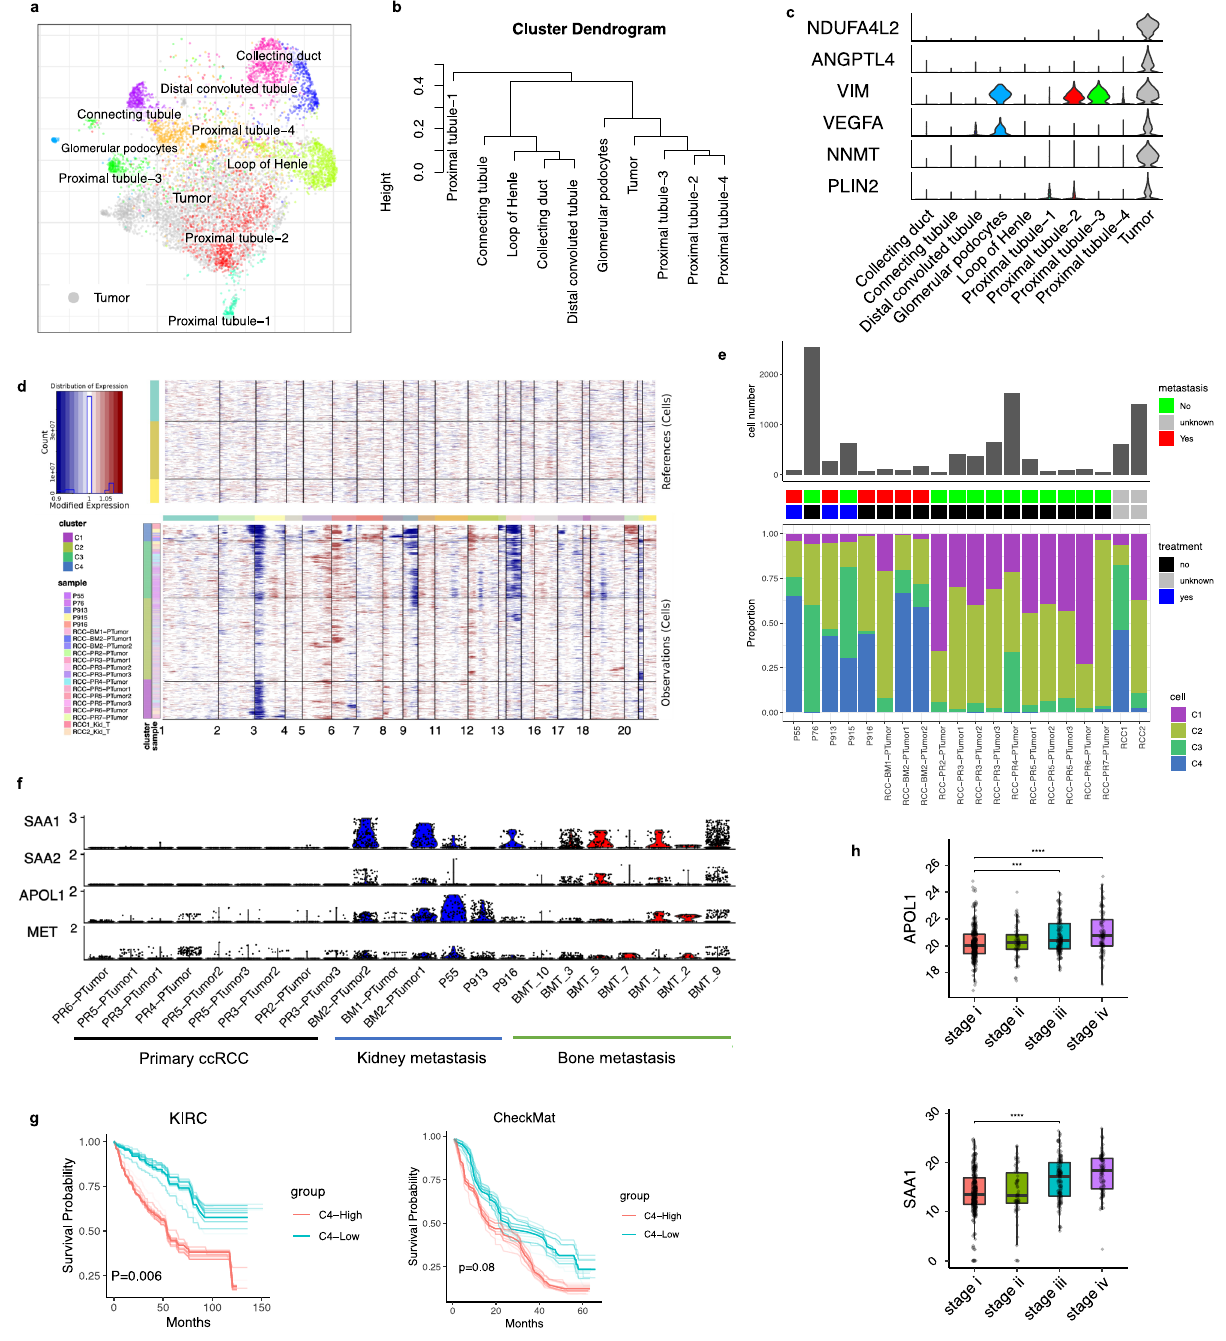
Fig. 3 | Intratumoral heterogeneity reveals distinctive malignant cell sub- clones.a Joint alignment ofnephron anatomy cells from normalkidney tissue and tumor cells from primary ccRCC tissue in UMAP embedding, colored by cell annotation. b Expression distance of different cell subpopulations is shown as a dendrogram. c Violin plot showing representative marker gene expression of tumor cells. d Inferred CNV pro fi le of tumor cells with normal nephron anatomy cells as normal reference. e Summary of tumor cell subclones, number of tumor cells (Top), clinic pathological features (middle), cell abundance of tumor sub- clones (bottom) in each sample. f Violin plot showing metastatic signature gene expression inpatient tumor cells from primaryccRCC, local kidney metastasisand bone metastasis. g Overall survival (OS) analysis for TCGA KIRC ( n =533) and